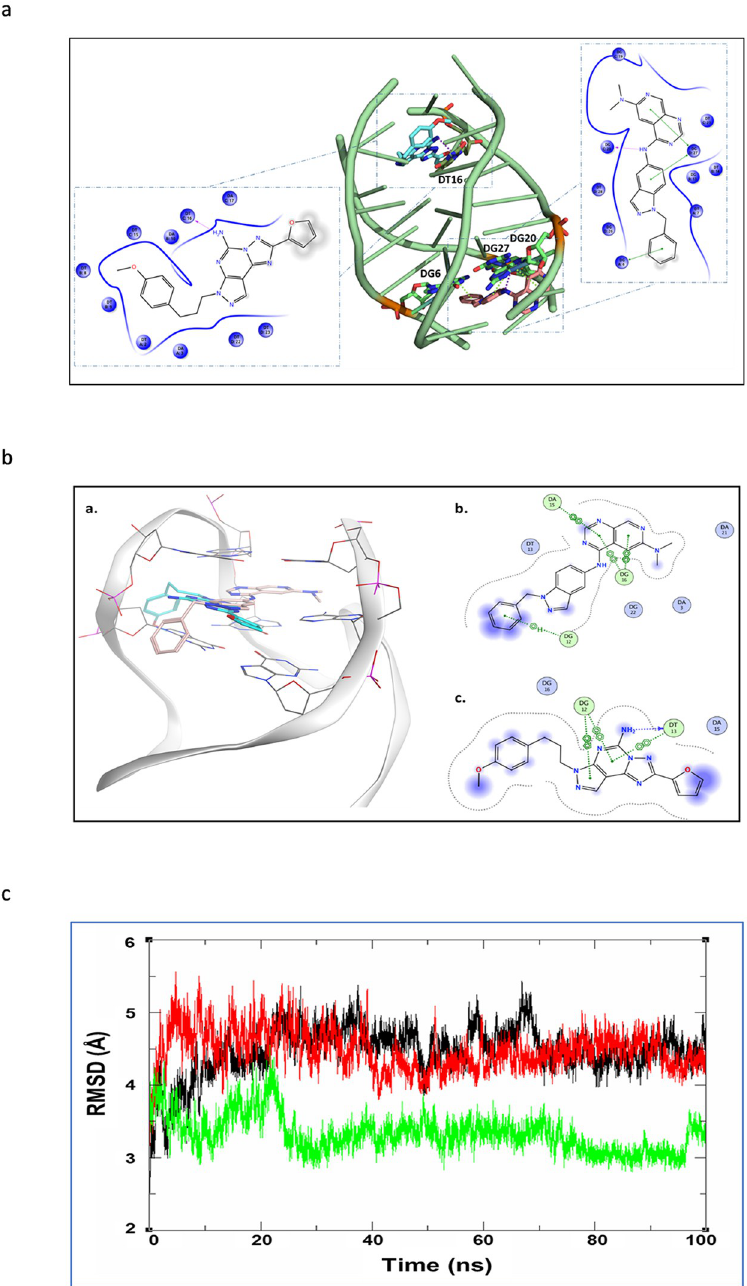
Fig 8. a. Docking of GW-2974 and SCH-442416 into the binding sites of the parallel human telomeric G- quadruplex DNA structure (2MS6) . Predicted binding modes of GW-2974 (pink sticks) and SCH-442416 (blue sticks) on G-quadruplex DNA (green sticks and cartoon). The 2D ligand interaction diagram shows the hydrogen bonding and π – π interaction as purple and green dotted lines, respectively. b. Docking of GW-2974 and SCH-442416 into the binding sites of the hybrid telomeric G-quadruplex DNA structure (6CCW) . The G-quadruplex DNA with the two docked compounds is shown in (a) . The 2D interaction diagrams show the binding modes of GW-2974 as pink sticks (a) and of SCH-442416 as green sticks in (b) . c. The RMSD analysis of the docked complexes of the Telomeric G-quadruplex DNA with GW2974 (black), SCH-442416 (red), and the co-Crystallized ligand